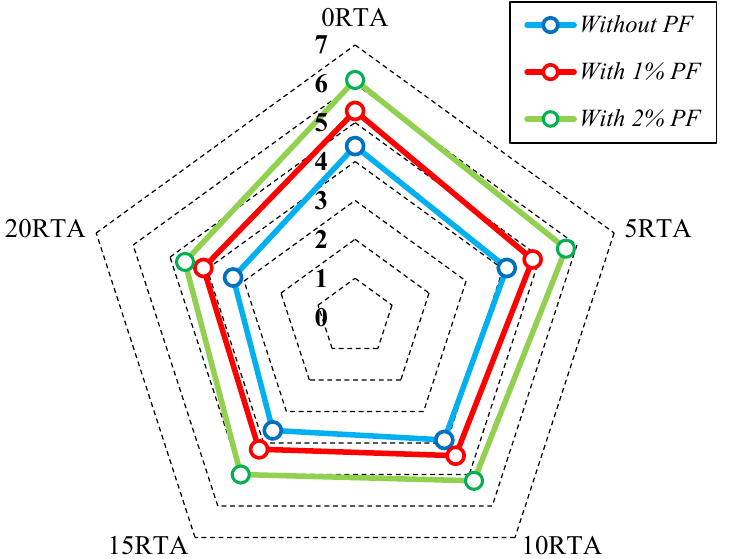
Materials 2022 , 15 , x FOR PEER REVIEW Figure 6. Influence of PF and RTA on the distribution of tensile resistance. Figure 6. Influence of PF and RTA on the distribution of tensile resistance. Figure 6. Influence of PF and RTA on the distribution of tensile resistance.